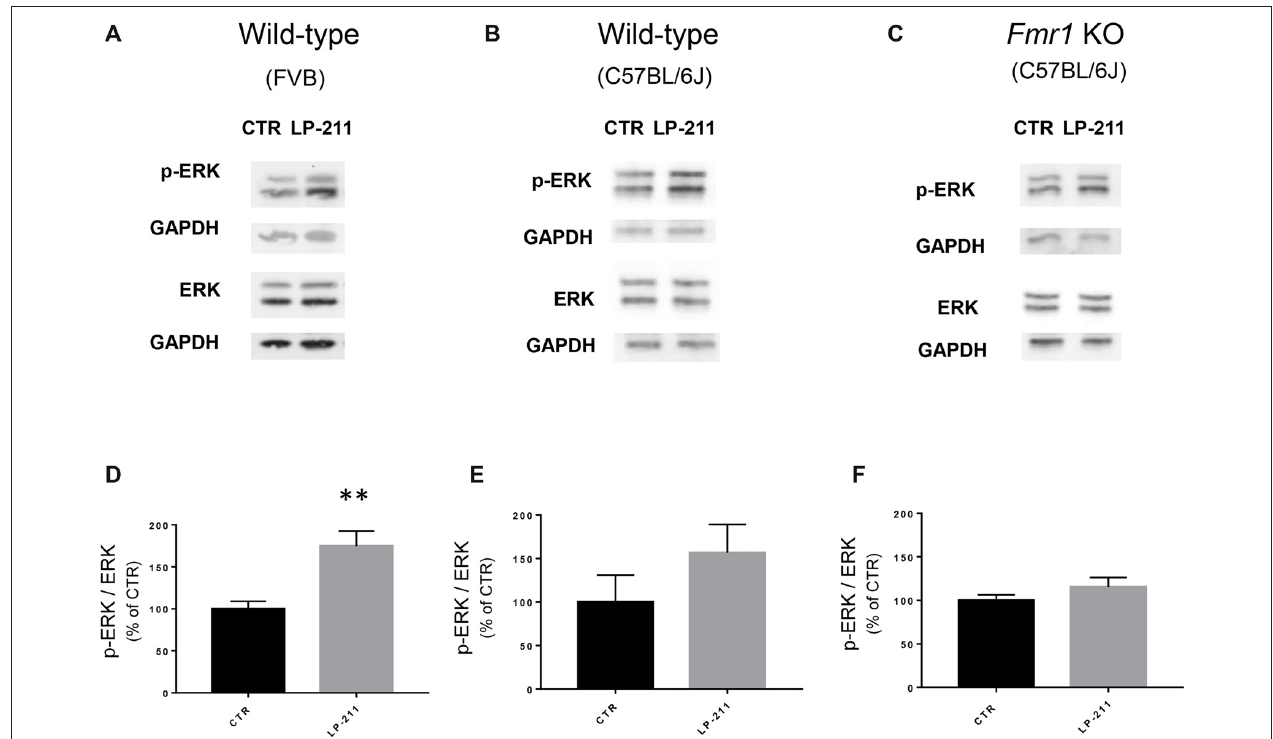
FIGURE 5 | Activation of 5-HT 7 receptors stimulated ERK phosphorylation. (A–C) Representative immunoblots showing the levels of phosphorylated and total ERK1/2 in control and LP-211 treated (10 nM, 5 min) hippocampal slices from WT (FVB strain; A ), WT (C57BL/6J strain; B ), and Fmr1 KO (C57BL/6J strain; C ) mice. (D–F) Semi-quantitative analysis of phosphorylated ERK1/2 vs. total ERK1/2 in control and LP-211 treated hippocampal slices from WT (FVB strain; D ), WT (C57BL/6J strain; E ), and Fmr1 KO (C57BL/6J; F ) mice. GAPDH was used as loading control. Relative optical density is presented as percentage of control. Data represent mean ± SEM of five (D) , four (E,F) separate experiments, each performed on a pool of three mice. ∗∗ p = 0.0064 by unpaired t -test. Full length immunoblots are shown in Supplementary Figures S2 , S3